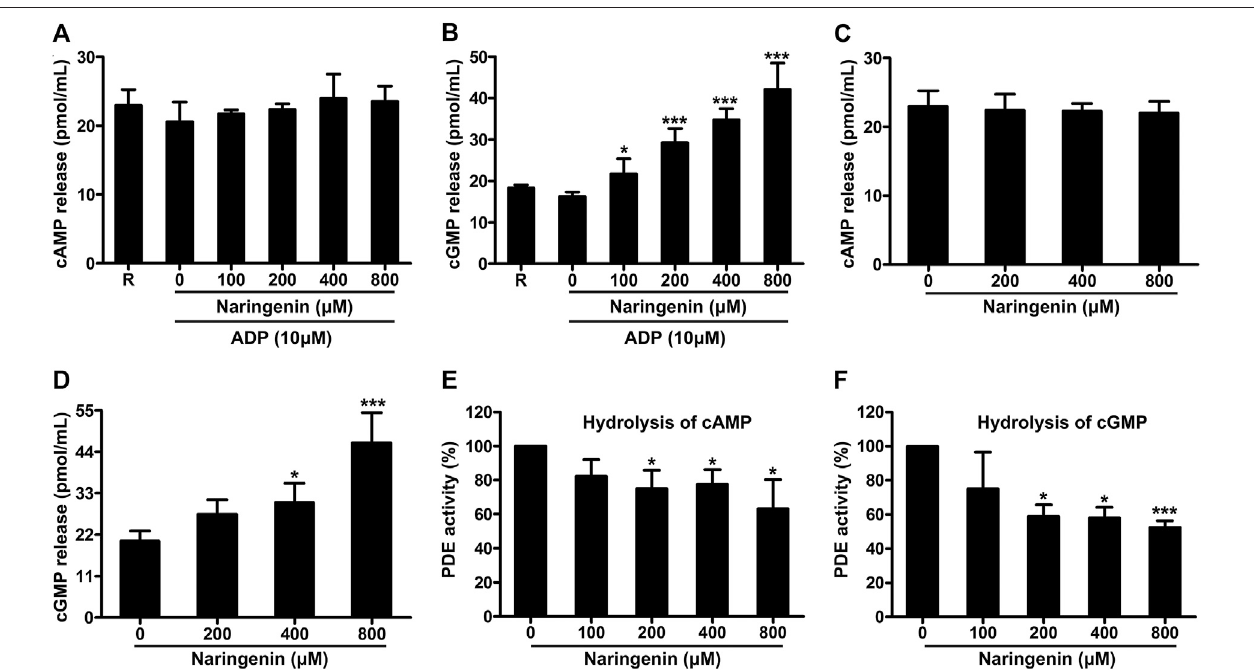
FIGURE 6 | Naringenin elevates platelet cGMP levels and inhibits phosphodiesterase activity. The levels of cAMP (A) and cGMP (B) in washed platelets preincubated withvehicleor naringenin (100, 200, 400, and 800 μ mol/L) were determined after stimulation with ADP (10 μ mol/L) using ELISAkits. Similarly, the levels of cAMP (C) andcGMP (D) weredetermined inrestingplateletsincubated withnaringenin(200,400,and800 μ mol/L)orvehiclefor5 min.RrepresentsthelevelsofcAMP or cGMP in resting platelets. Data are expressed as means ± SD ( n (cid:2) 4). * p < 0.05, *** p < 0.001 compared with the vehicle control group. The effects of naringenin on phosphodiesterase activity were measured by HPLC on the hydrolysis of cAMP (E) and cGMP (F) . The level of phosphodiesterase activity obtained with vehicle control (0 μ M) was taken as 100%. Data are expressed as means ± SD ( n (cid:2) 3). * p < 0.05, *** p < 0.001 compared with the vehicle control group.